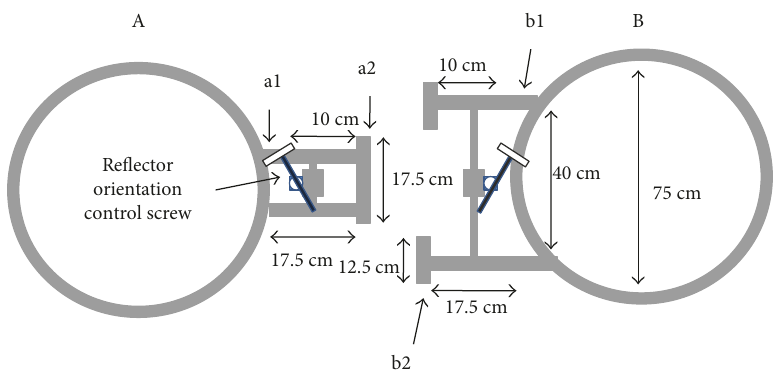
Figure 3: Schematic diagram of the dual parabolic re fl ector support system with dimensions.